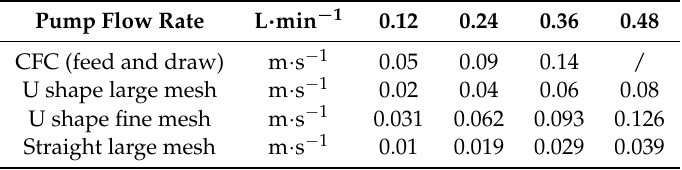
Table 1. CFV associated with a range of pump flow rate tested for CFC (feed and draw) and submerged modules (draw).